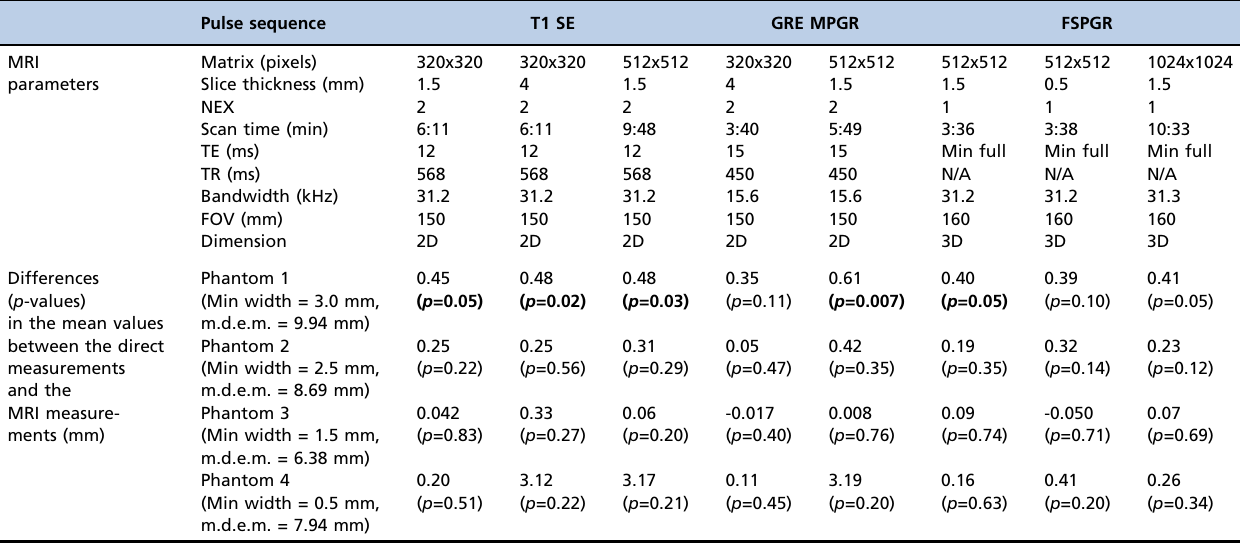
Table 1 - Magnetic resonance imaging sequence parameters and statistically significant differences ( p -values) between the mean direct measurements and the mean MRI measurements (shown in bold). Pulse sequence T1 SE GRE MPGR FSPGR MRI Matrix parameters